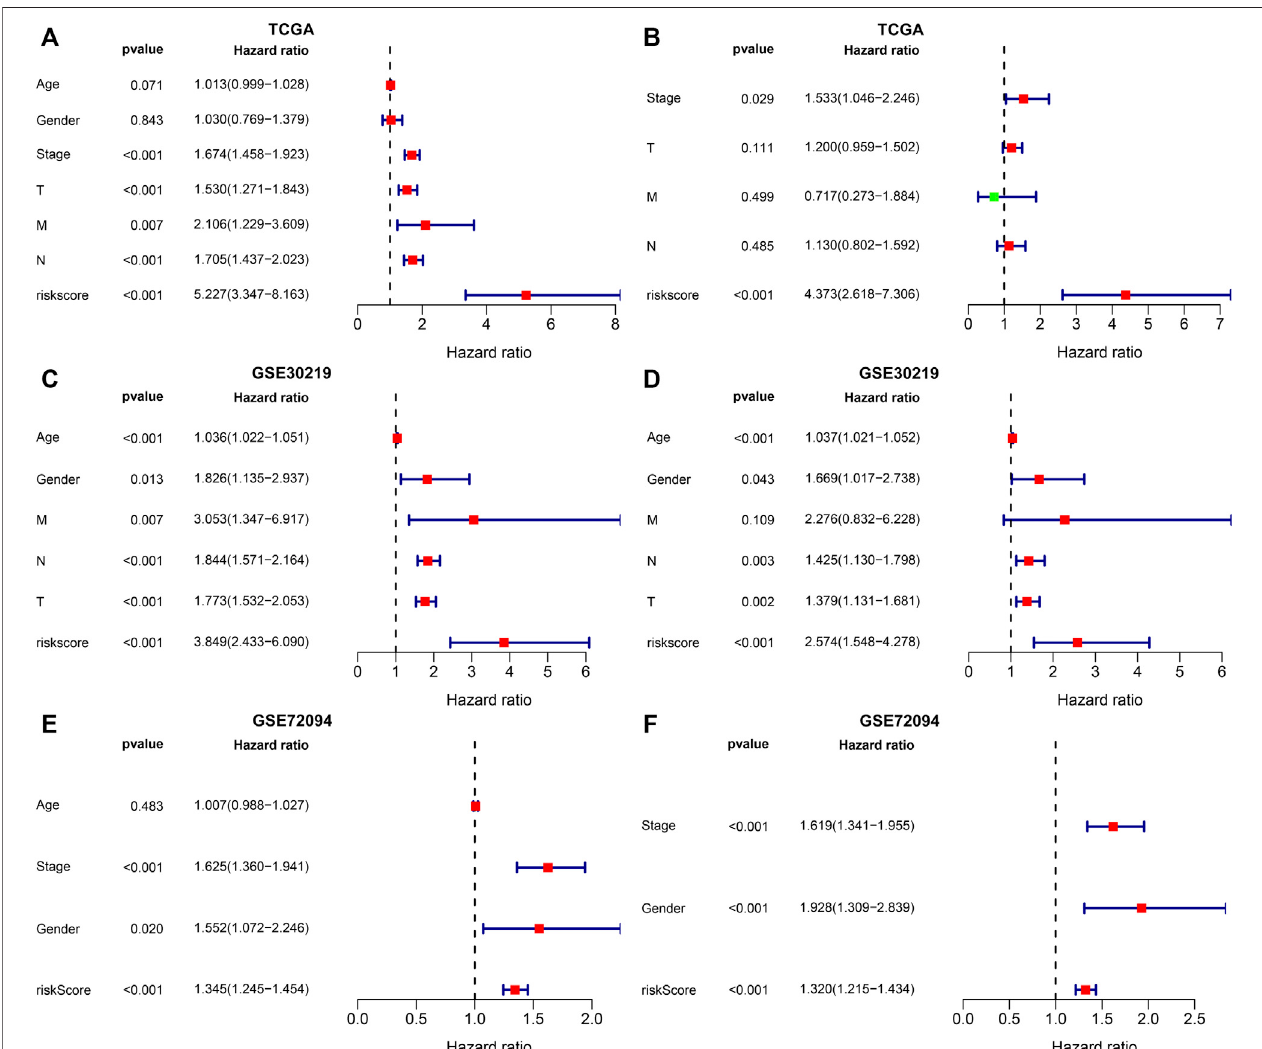
FIGURE7| Evaluationandexternalveri fi cationofthepredictiveindependencyofthem 6 AriskscoreinLUADpatients. (A) Univariate-coxregressionanalysisforthe correlationsbetweenthem 6 Ariskscoreand LUADpatients ’ OSintheTCGA dataset. (B) Multivariate-cox regression analysisfor assessing theindependent prognostic factors in the TCGA dataset. (C) External validation of the correlations between the m 6 A risk score and LUAD patients ’ OS in the GSE30219 dataset by univariate-cox regression analysis. (D) External validation of the independent prognostic factors in the GSE30219 dataset through multivariate-cox regression analysis. (E) External veri fi cation of the relationships of the m 6 A risk score with LUAD patients ’ OS in the GSE72094 dataset through univariate-cox regression analysis. (F) External veri fi cation of the independent prognostic factors in the GSE72094 dataset through multivariate-cox regression analysis.